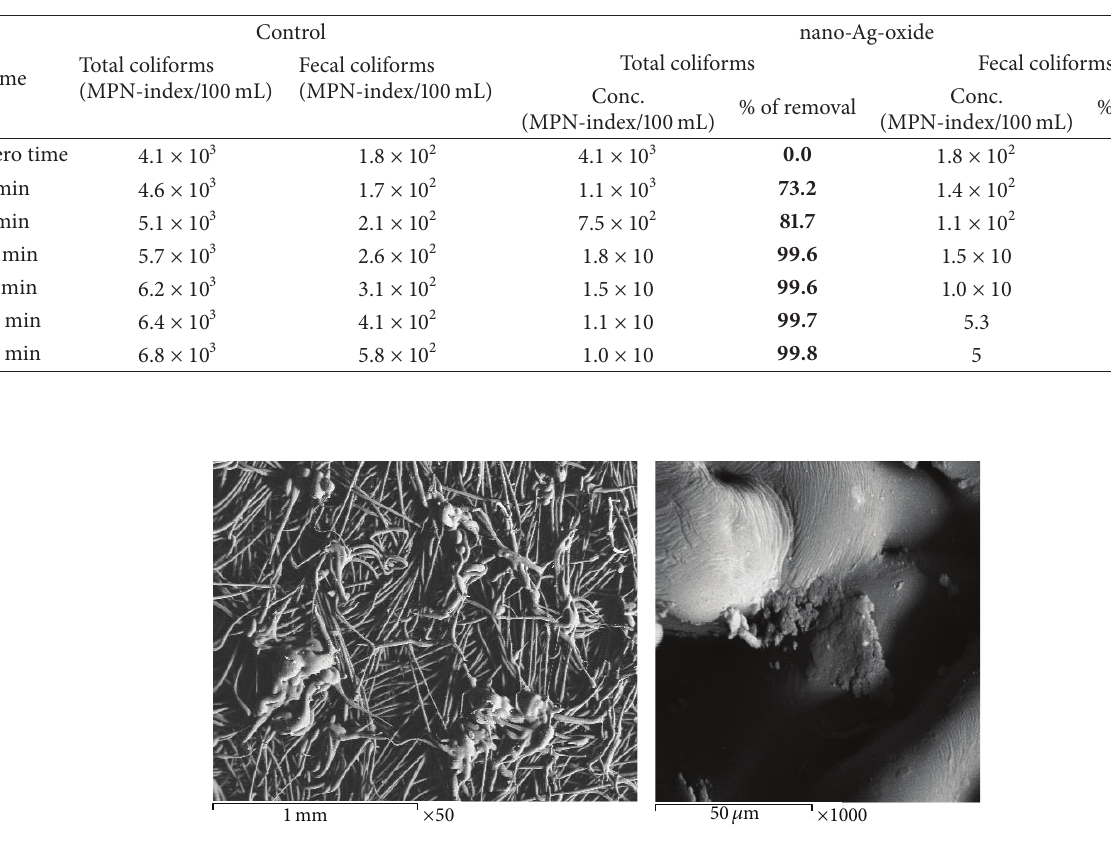
Figure 6: Cross-sections of treated polyester fabric taken after